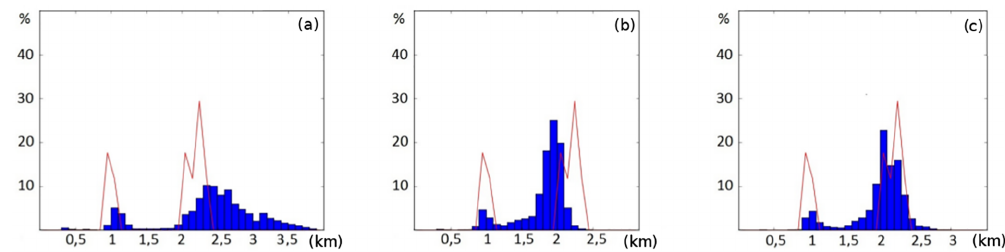
Figure 12. Sensitivity of the stereo calibration step illustrated by the first shot in the altocumulus validation case. For this shot, we represent the height–frequency histogram obtained with (a) no stereo calibration, (b) stereo calibration parameters obtained with the first shot pair of images, and (c) stereo calibration parameters obtained with the second shot pair of images.